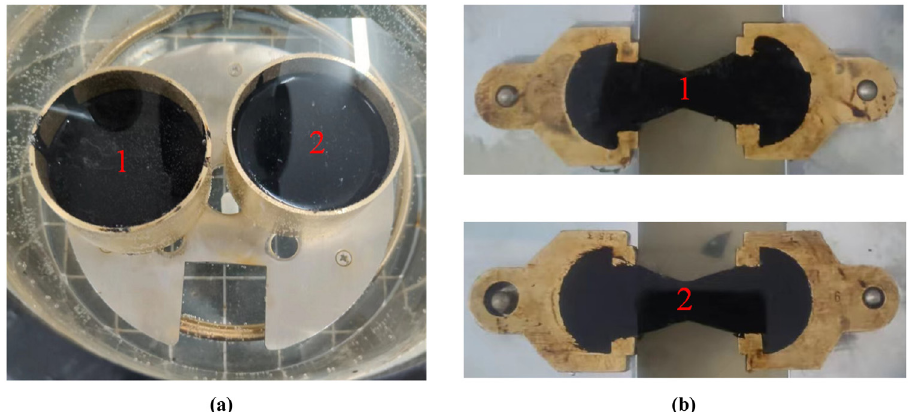
Figure 17: Experiment of basic indexes of asphalt: ( a ) penetration test and ( b ) ductility test. Note: 1. Original asphalt; 2. PU - modi fi ed asphalt.